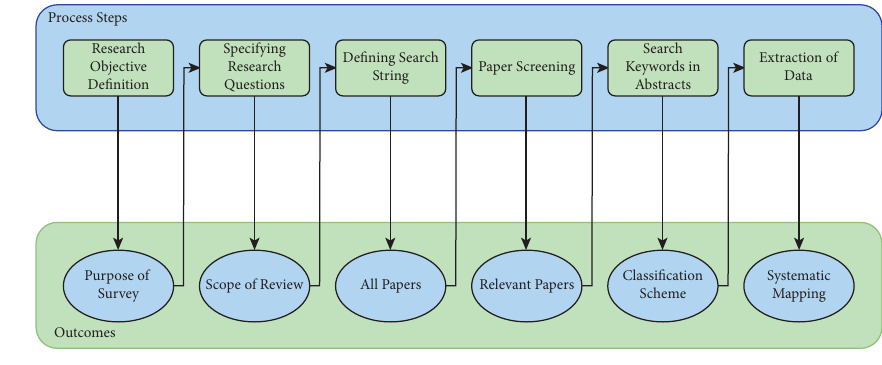
Figure 2: Research methodology.